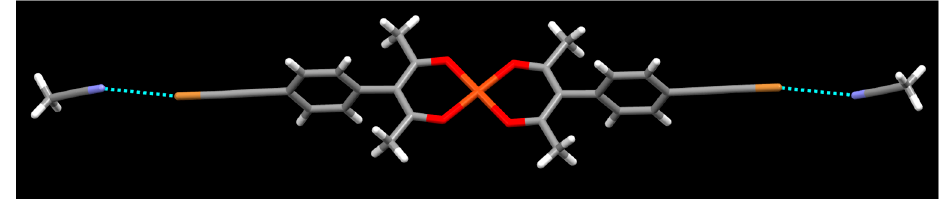
Figure 6. Part of the crystal structure of [Cu( L2 ) 2 ]·2CH 3 CN showing the geometry around the metal ion and the ligand-solvent halogen bond (color codes: red—oxygen; blue—nitrogen; gold—bromine; orange—copper).